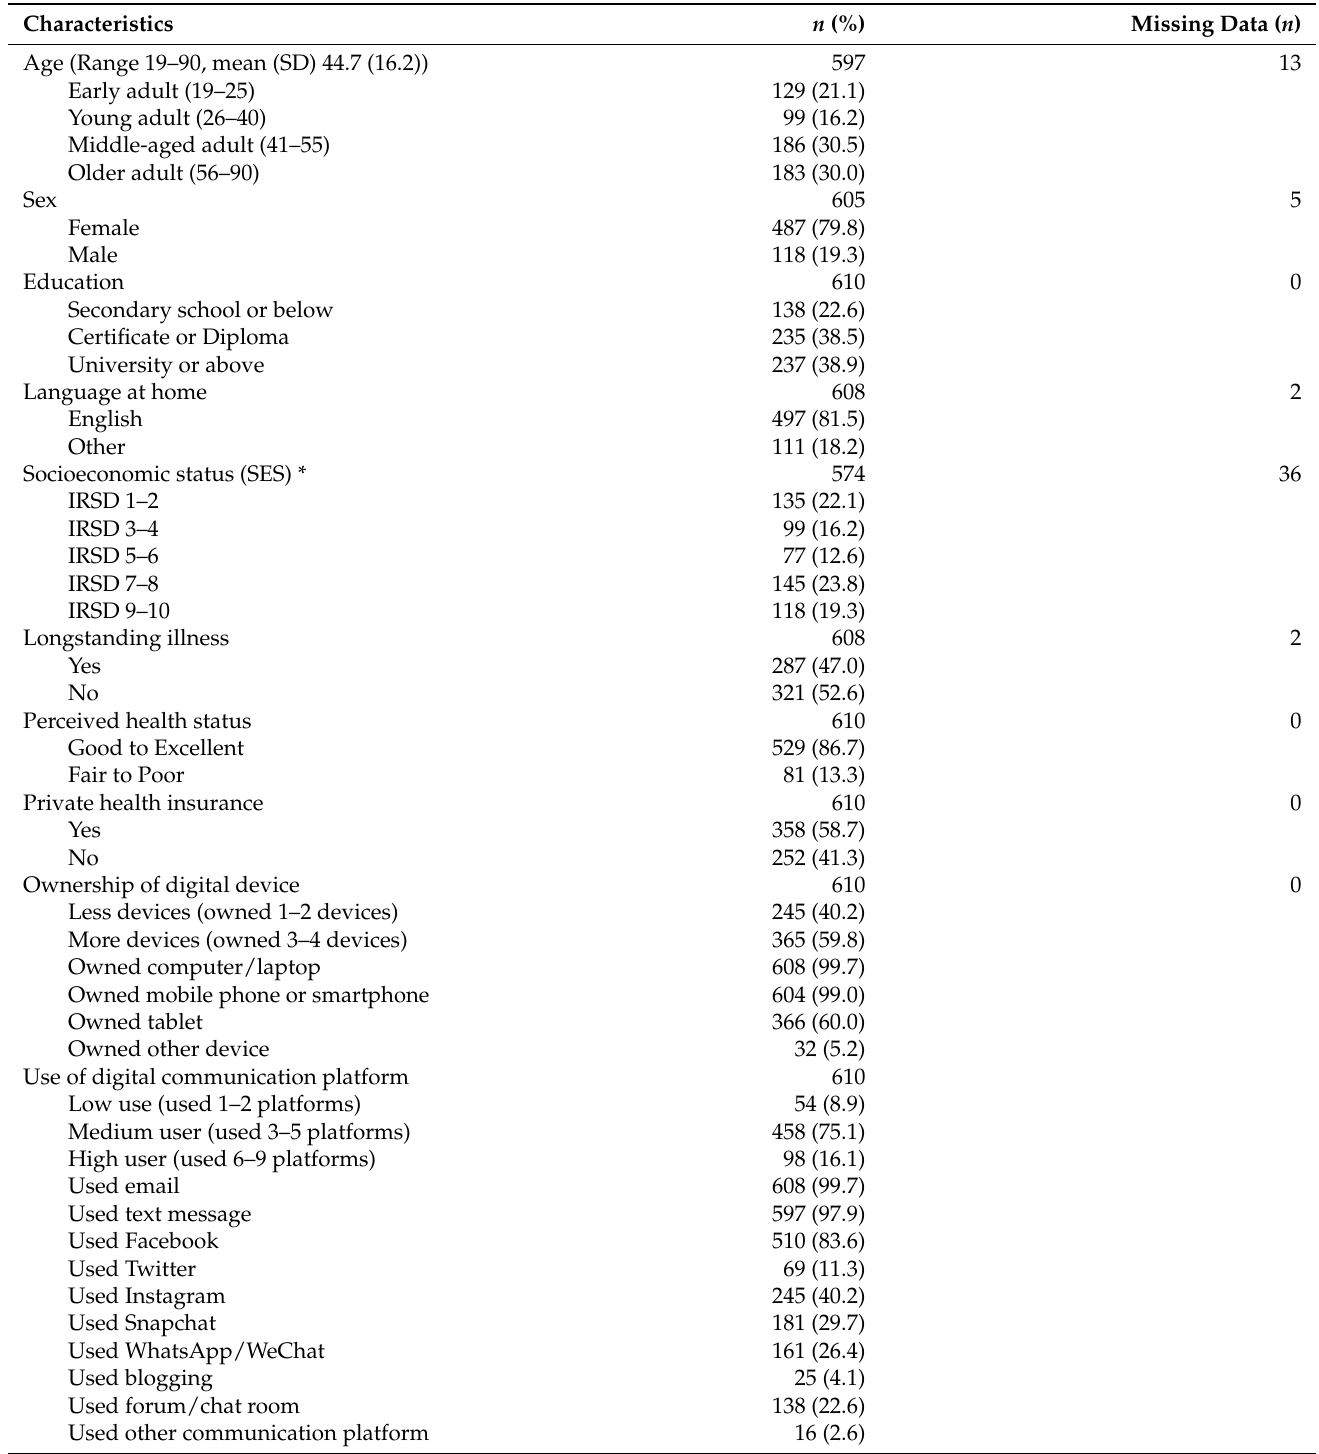
Table 1. Sociodemographic characteristics of participants ( n =